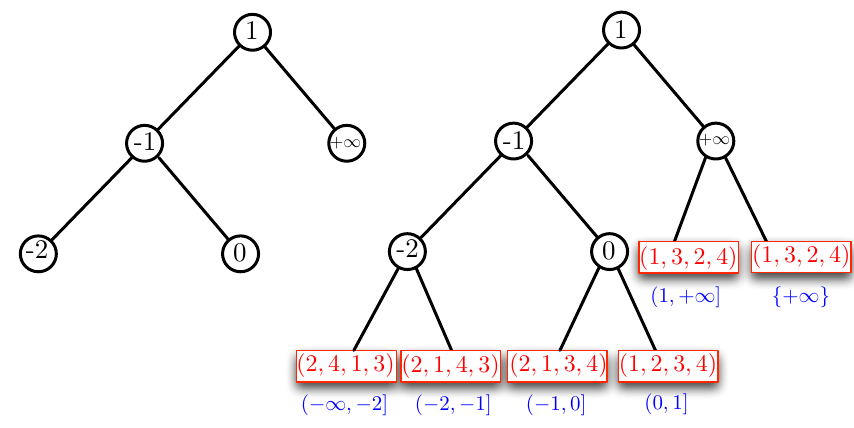
Figure 5. The AVL tree for the slopes L ( P ) ( right ) for the set P of Example 3. The blue intervals indicate the slope set covered by a